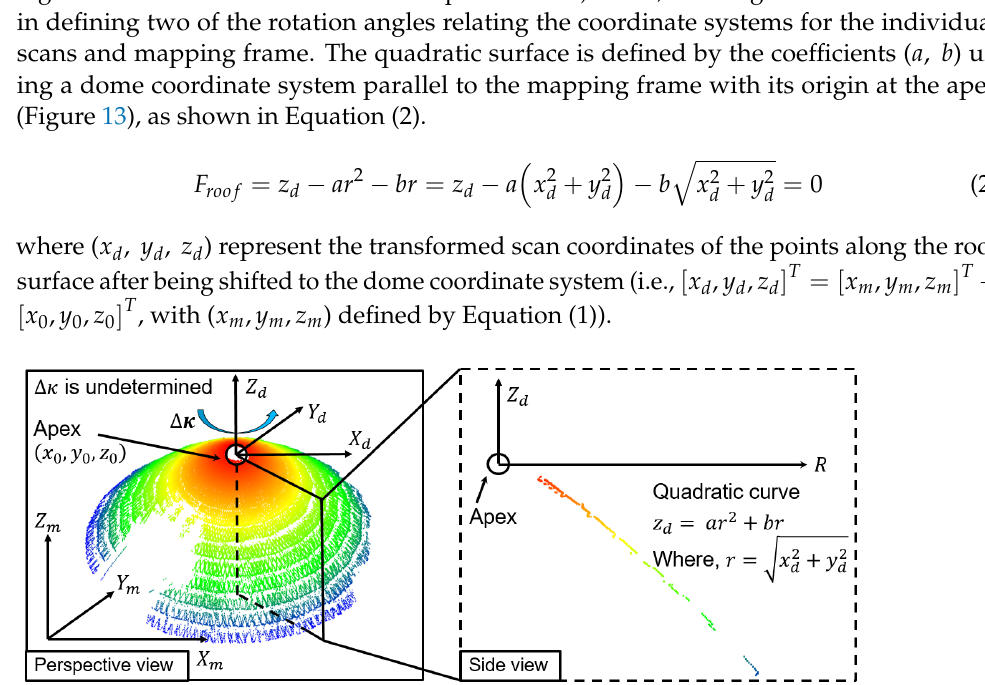
Figure 13. Coordinate system definition and parametric model for the roof feature with the axisym- metric characteristic of the roof feature ( left ) together with a vertical profile through the roof ( right ).